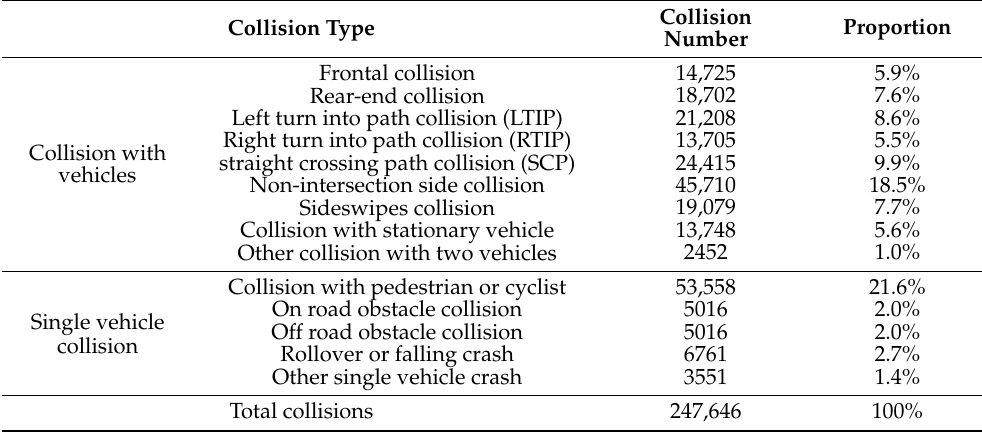
Table A1. The detailed distribution of different collision types in road collisions in China.